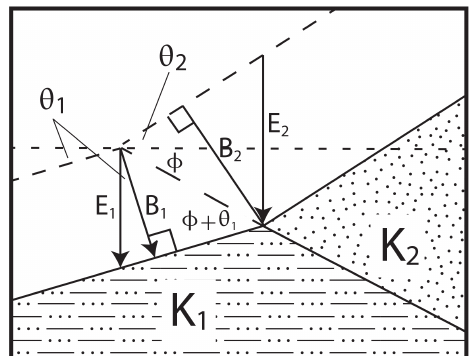
Figure A1. Geometric relationships used to derive the equation for continuity of the channel at a contact between two rock types. Note that the slope of the contact plane ( S c = − tan φ ) is defined as posi- tive when the contact dips in the downstream